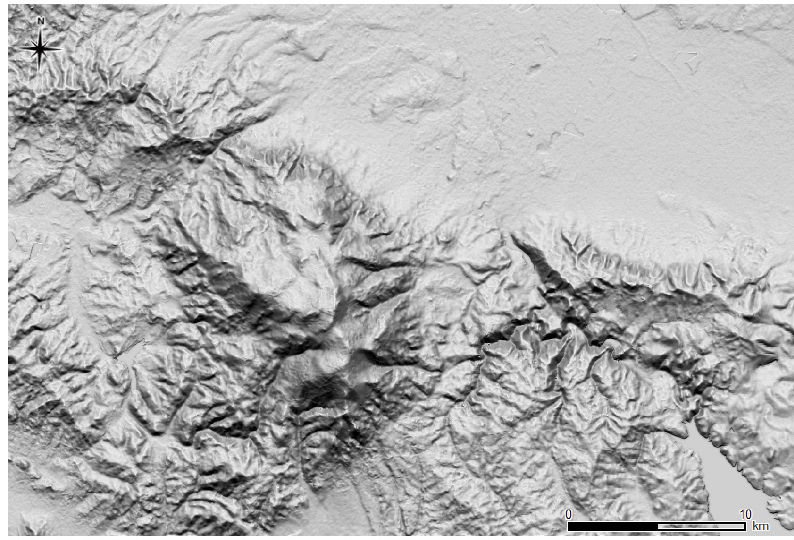
Fig. 5. Relief visualization with two-directional hillshade and